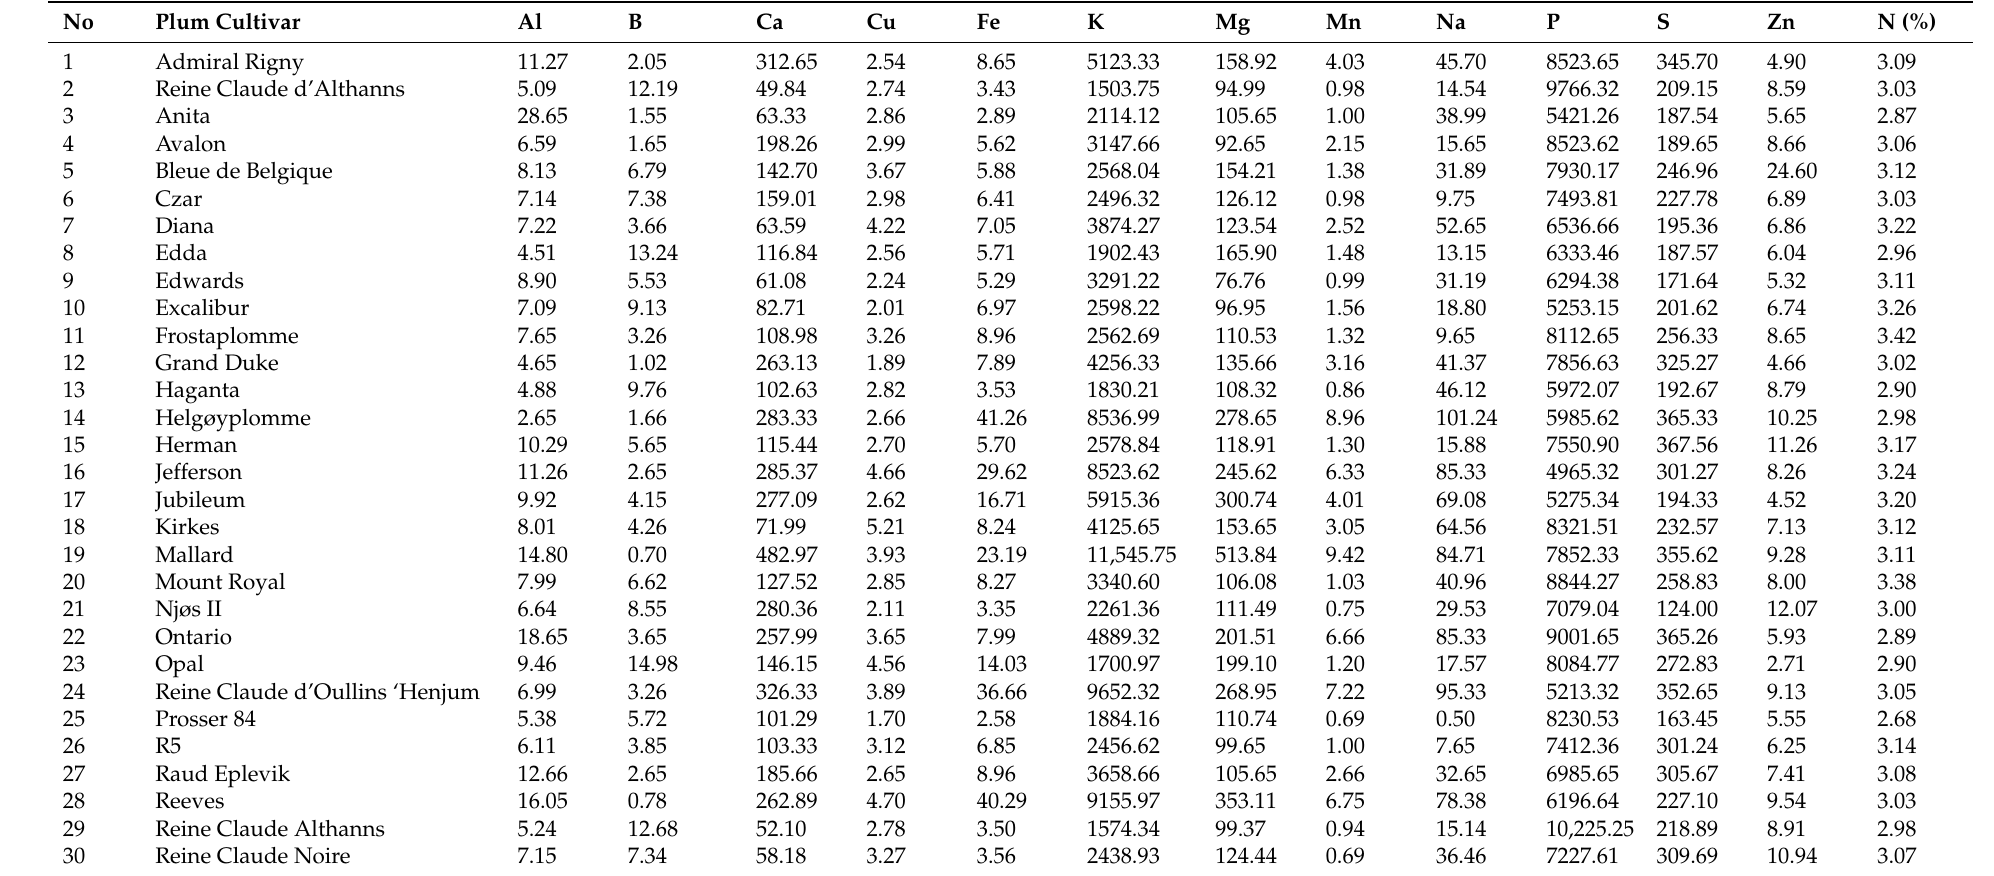
Table A1. Content of nutrients (mg/kg) in 68 Norwegian plum cultivars from Njøs (42 samples) and NIBIO Ullensvang (8 samples) collected in 2019 and 2021 and from NMBU (18 samples) collected in 2019 and